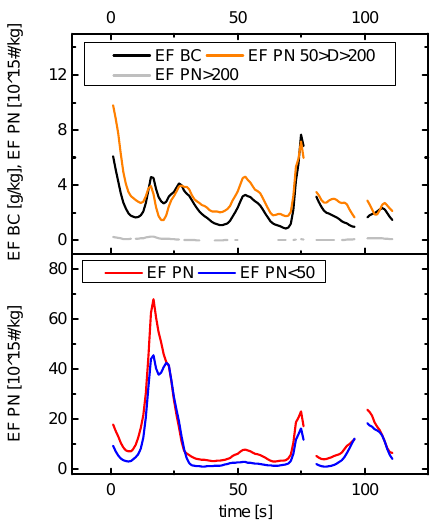
Figure 7. A sample of chasing emission factors for black carbon (BC) and particle number (PN) for different size fractions for D3- 02: BC (black), total PN (red), PN of particles smaller than 50nm (blue), PN of particles from 50 to 200nm (orange) and PN of parti- cles larger than 200nm